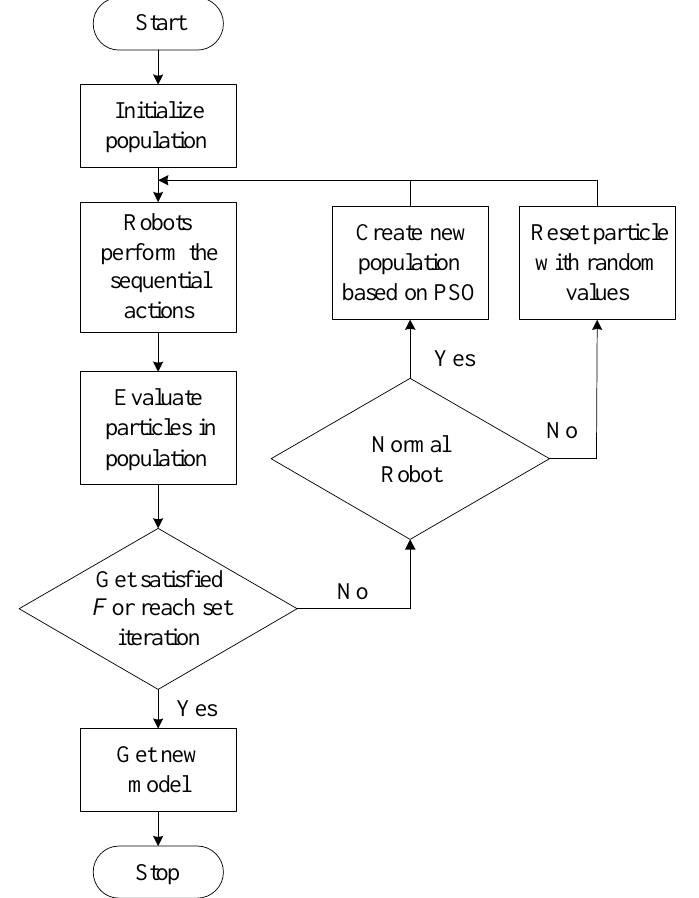
Figure 9. The procedure of an evolutionary based self-recovery